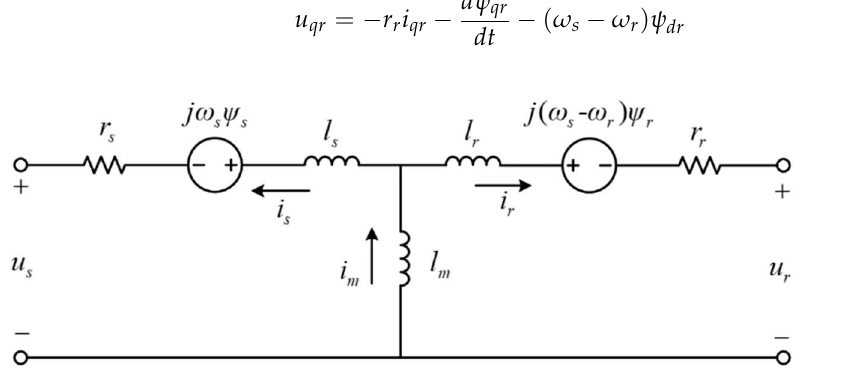
Figure 4. Equivalent circuit of the DFIG.